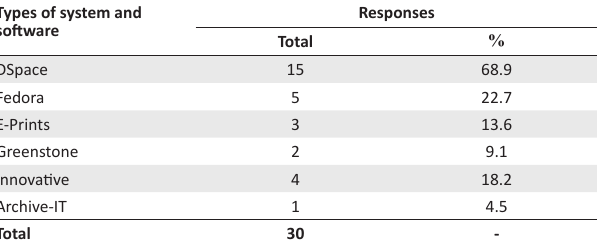
TABLE 2: Types of systems and software used for digital preservation practices.